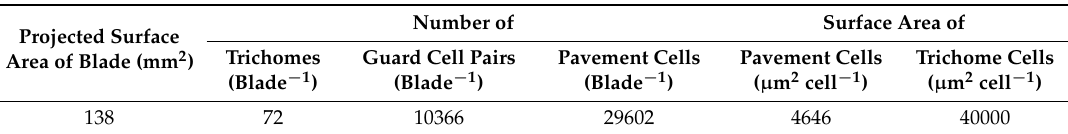
Figure 2. Chemical structures of major cuticular wax compound classes.